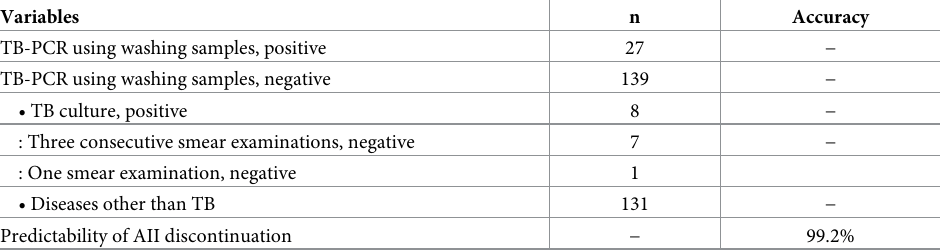
Table 3. Prediction of the discontinuation of airborne infection isolation using bronchoscopy samples.